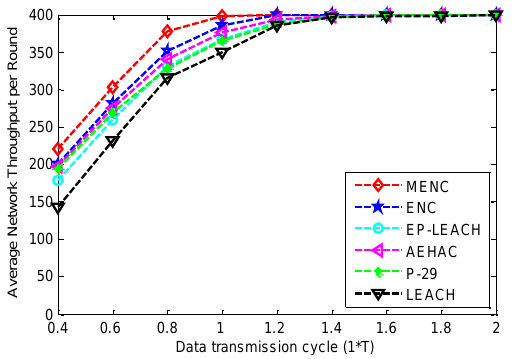
Figure 6. The comparison of ANTR among MENC, ENC, EP-LEACH, AEHAC, P-29 and LEACH for different data transmission cycles.